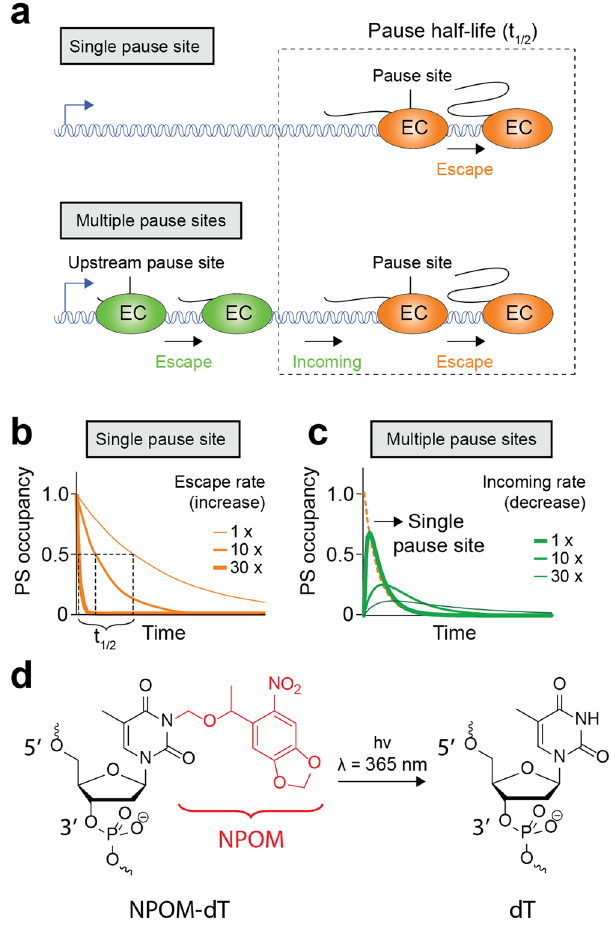
Fig. 1 Transcriptional pausing in the context of single and multiple pause sites. a Schematics of single (top panel) and multiple (bottom panel) pause sites. The pause half-life is characterized by the rate of EC escape from the pause site (indicated by dotted rectangle). In the case of multiple pause sites, EC escaping from upstream sites may enter in downstream pause sites. b Simulations of single pause site occupancy by EC as a function of time. The rate of pause escape is inversely proportional to the pause half- life, as observed by the faster decrease of pause site occupancy when increasing the rate of EC escape. c Simulation of multiple pause sites occupancy by EC as a function of time. The variation in upstream pause escape modulates the observed half-life of a downstream pause. It can be observed that decreasing rates of upstream pause escape increases the observed half-life of the downstream pause (green curves). The occupancy of a single pause site is shown as reference (orange curve). d Chemical structure of an NPOM-caged dT and an unmodi fi ed dT following cleavage by ultraviolet ( λ = 365 nm)